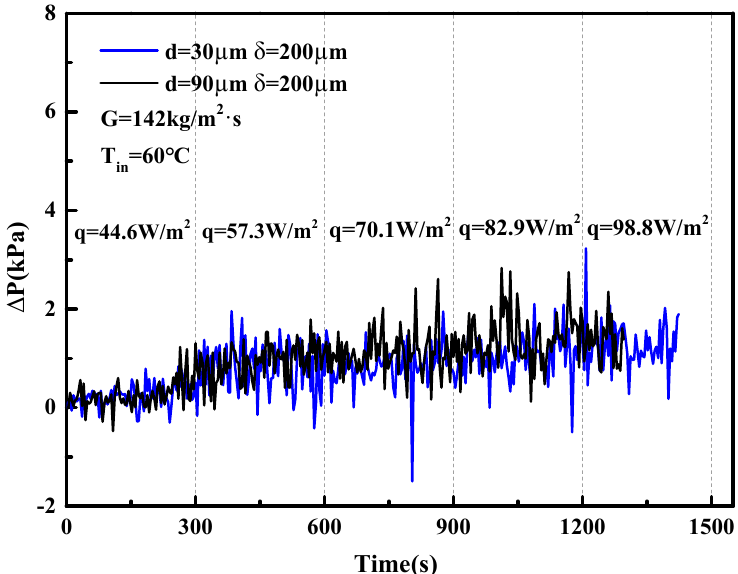
Figure 11. Pressure drop fluctuation of porous microchannel samples ( δ = 200 μ m).